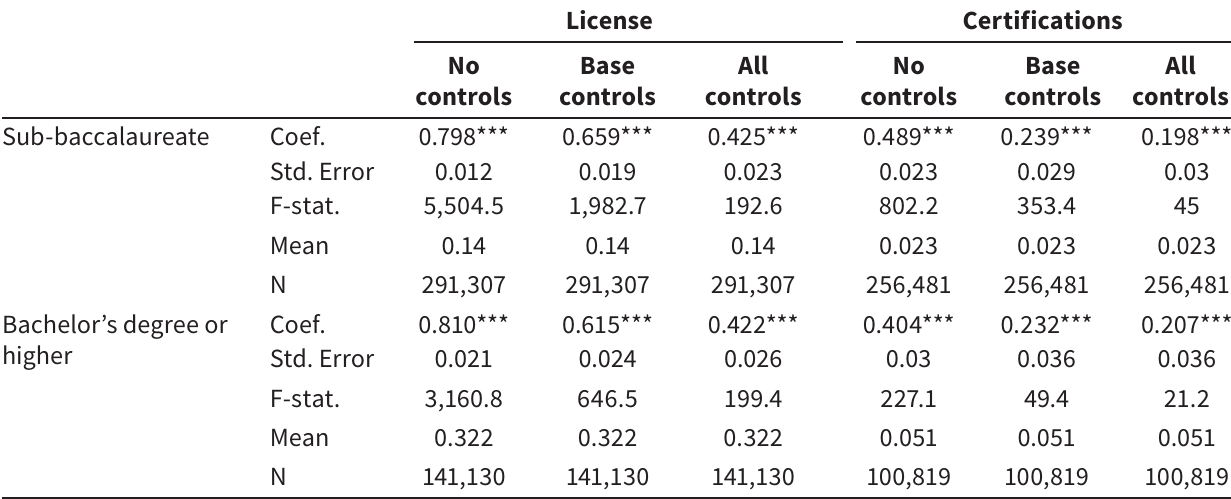
Figure 1 Average labor market outcomes by credential status and level of education. Table 3 First-stage regressions predicting credential receipt License Certifications